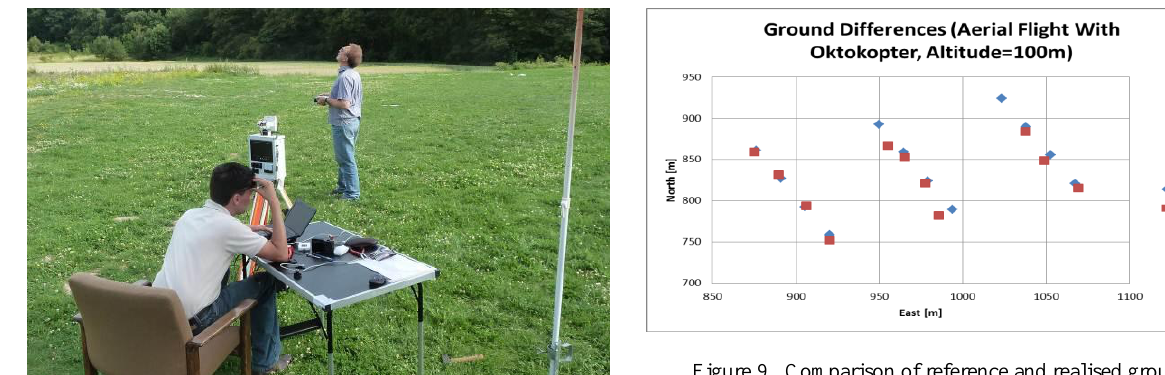
Figure 9. Comparison of reference and realised ground positions during aerial